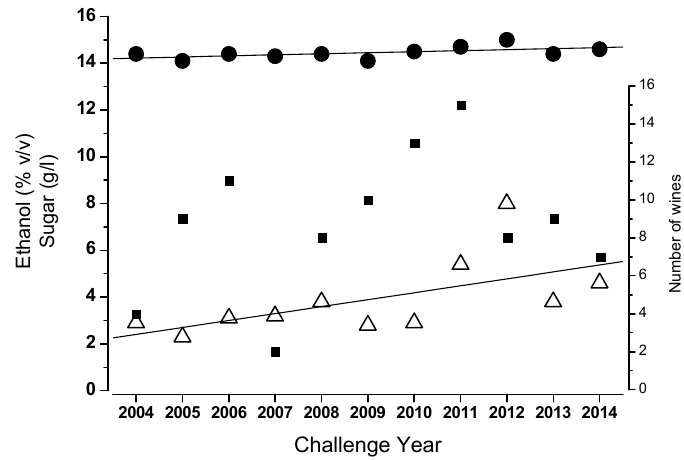
Figure 1. Evolution of ethanol ( ● ) and sugar ( ∆ ) concentrations of red wines awarded as “Great Gold” ( ▪ number of wines) in the Mundus Vini wine challenge. Values were obtained from www.mundusvini.com (accessed between May and July 2014).